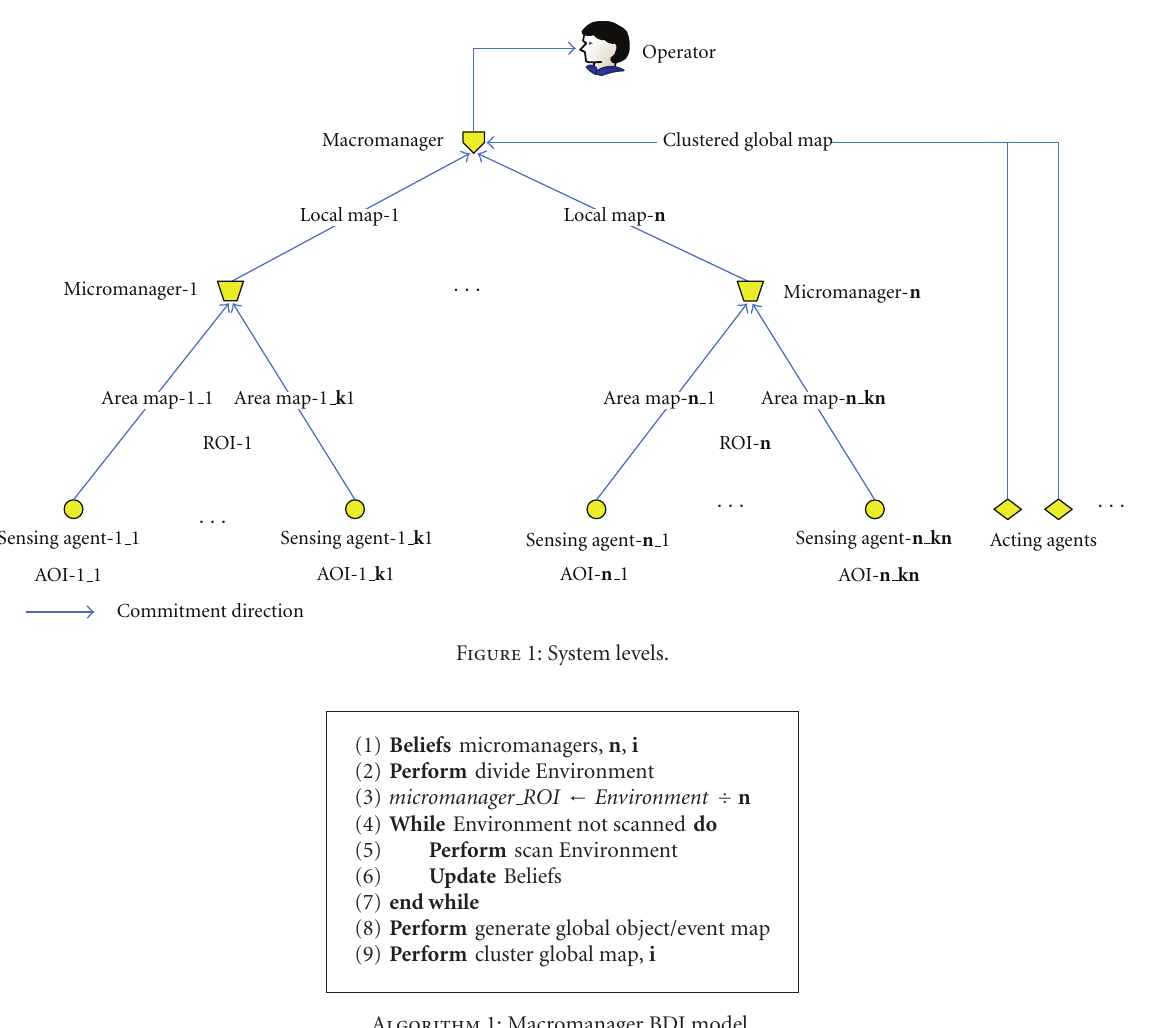
Algorithm 1: Macromanager BDI